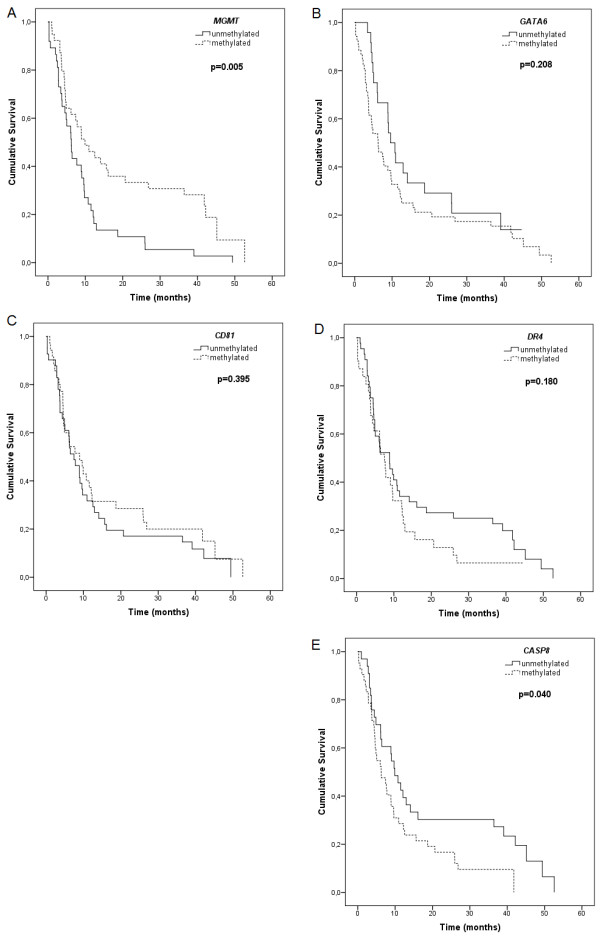
Kaplan-Meier cumulative survival (months) in glioblastoma patients. According to promoter methylation status of (A) MGMT gene (log-rank test, χ2=7.997, df = 1, P = 0.005), (B) GATA6 gene (log-rank test, χ2 = 1.582, df = 1, P = 0.208), (C) CD81 gene (log-rank test, χ2 = 0.719, df = 1, P = 0.395), (D) DR4 gene (log-rank test, χ2 = 1.800, df = 1, P = 0.180), and (E) CASP8 gene (log-rank test, χ2 = 4.214 df = 1, P = 0.040).